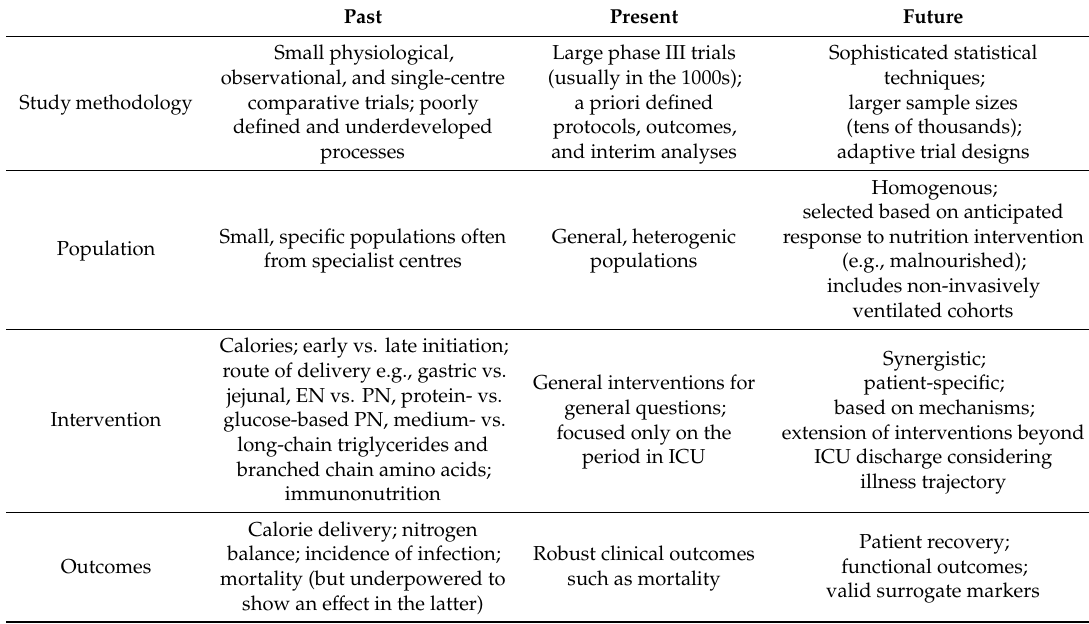
Table 1. Summary of critical care nutrition study design in the past, present, and